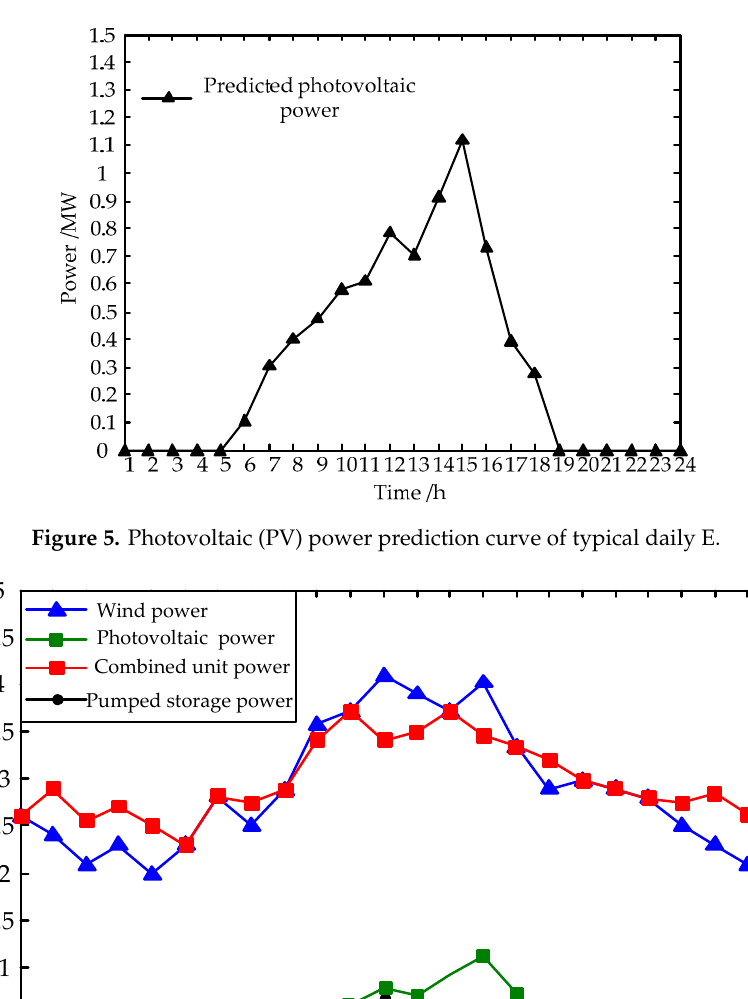
Figure 4. Typical daily power curves of A, B, C, and D obtained by wind farm prediction.